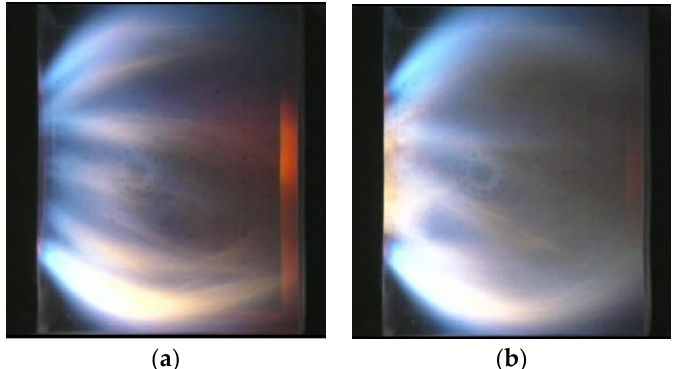
Figure 21. Actual images of the flame under cruising conditions and in staged mode: ( a ) case P and ( b ) case M.